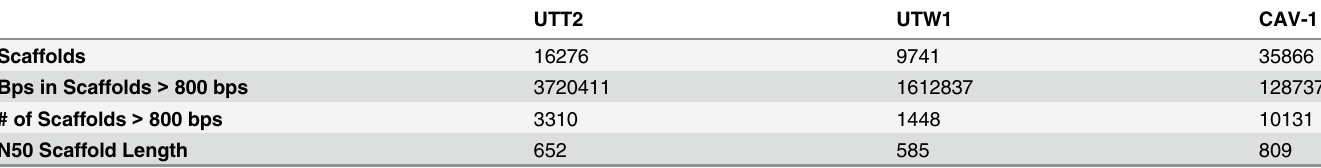
Table 1. Summary of 127 k-mer assemblies using SOAPdenovo-trans.